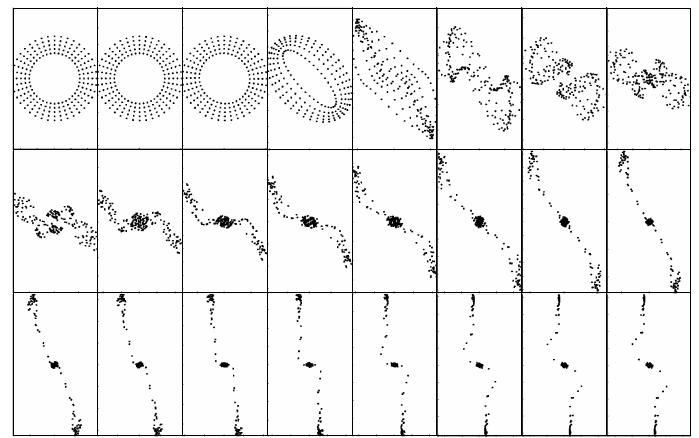
Fig. 2. Examples of retrograde orbits with initial conditions E = (cid:0) 1 : 2, h = (cid:0) 0 : 3, computed over the time interval (cid:28) = [0 ; 10]. Each panel contains 2D results of the calculation ( x and y ), the scale of the axes increases with time. The top left panel shows the star positions at (cid:28) = 0, x 2 [ (cid:0) 0 : 5; 0 : 5], y 2 [ (cid:0) 0 : 8; 0 : 8], and both time and scale increase from left to right and from top to bottom. The bottom right panel shows the positions at (cid:28) = 10, x 2 [ (cid:0) 10 : 0; 10 : 0], y 2 [ (cid:0) 20 : 0; 20 : 0].